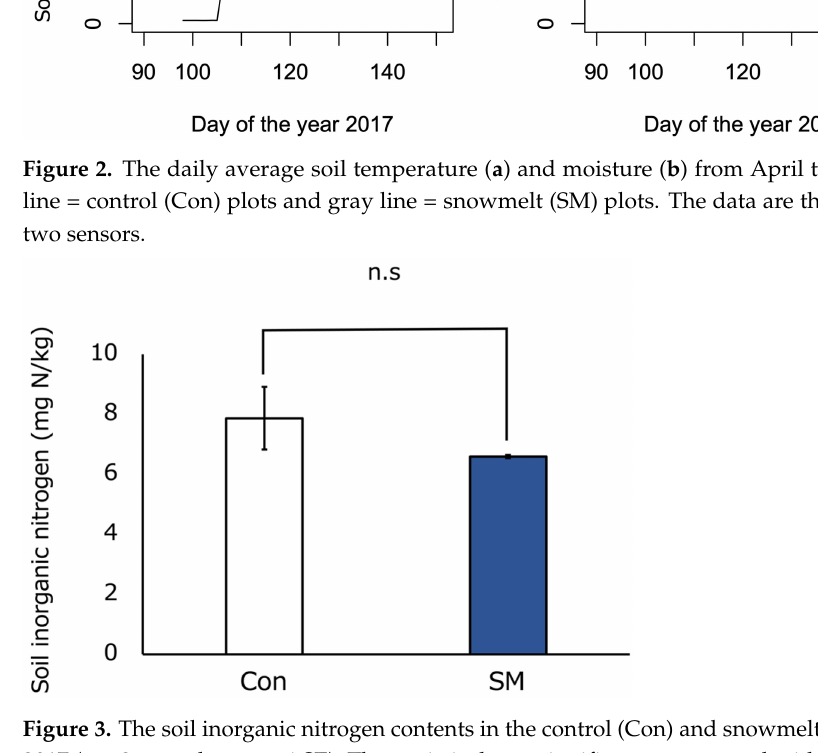
Figure 3. The soil inorganic nitrogen contents in the control (Con) and snowmelt (SM) plots in June 2017 (n = 3, error bars are ± SE). The statistical non-significance was tested with a Wald test. n.s. =